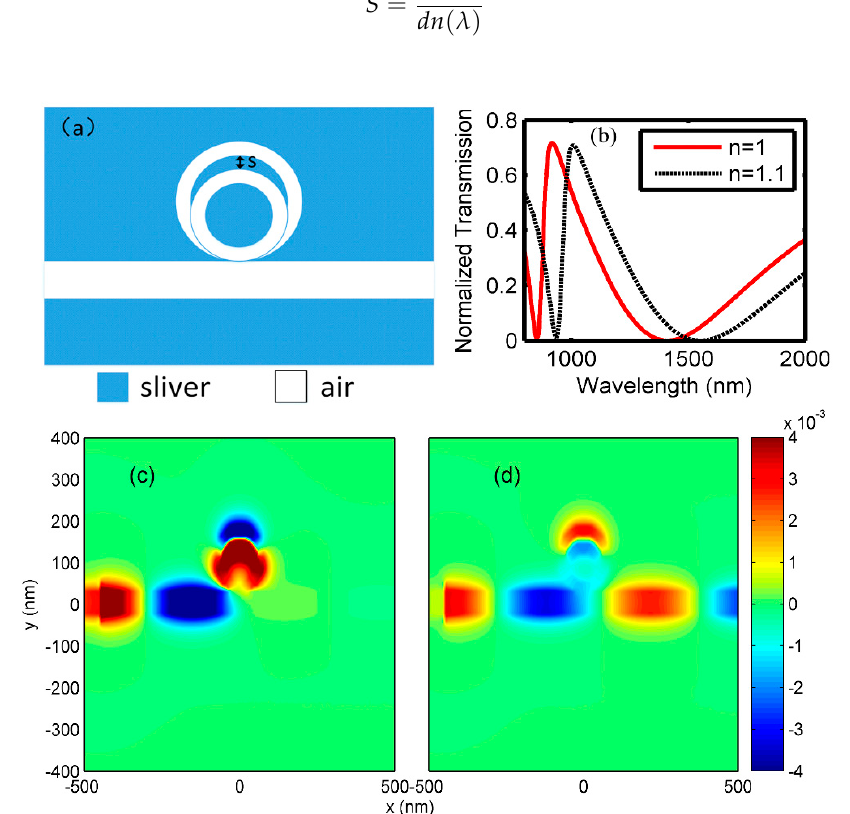
Figure 2. ( a ) Double-ring resonator structure; ( b ) transmission spectrum; ( c ) magnetic field at dip λ = 854 nm trough; and ( d ) magnetic field at peak λ = 920